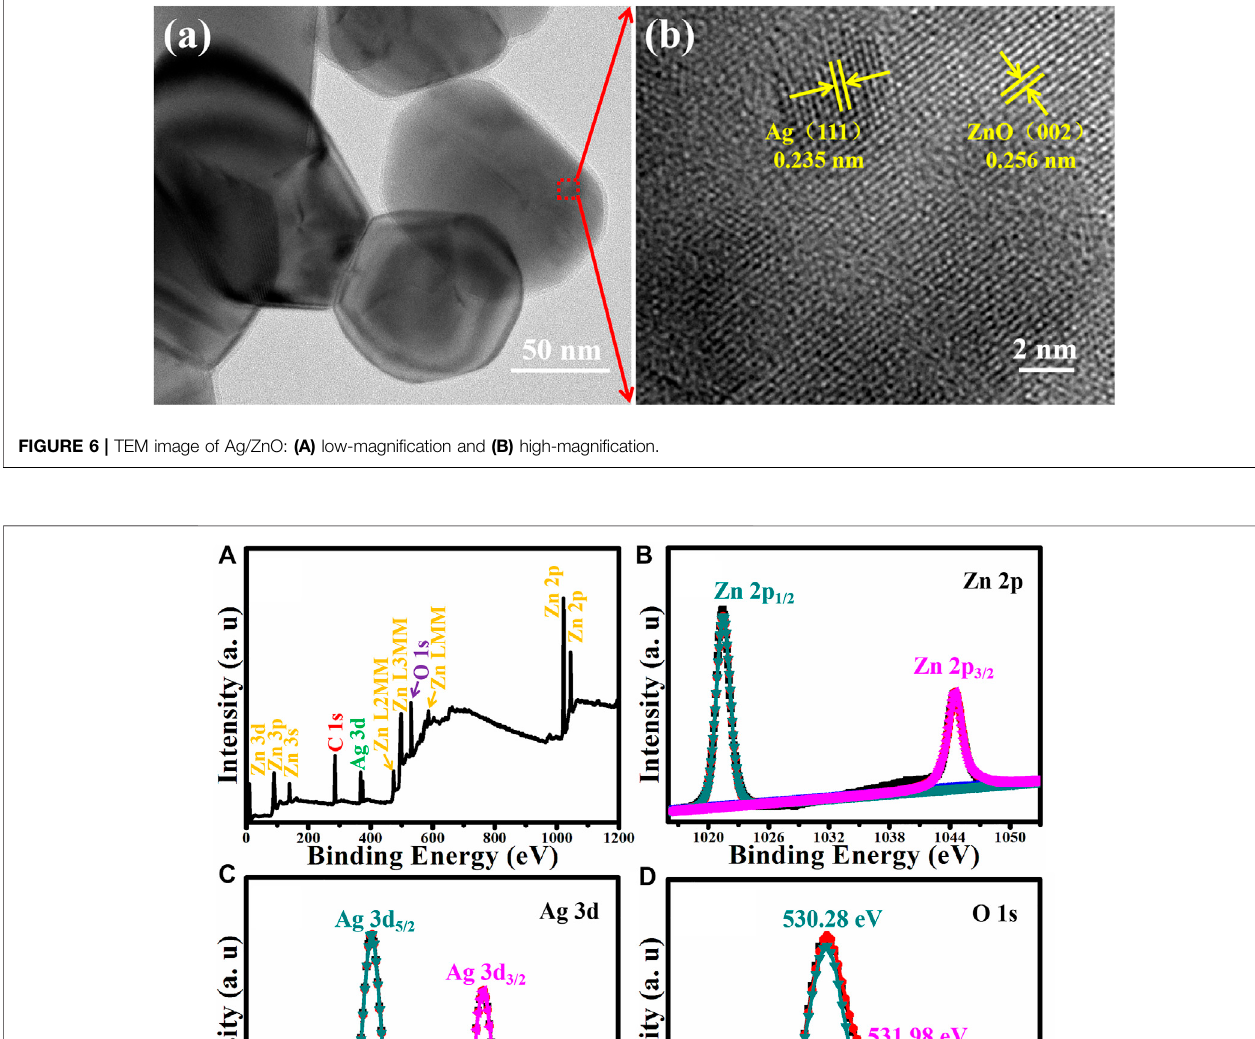
Frontiers in Energy Research |